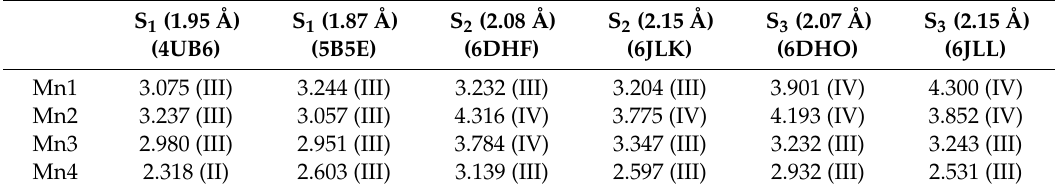
Table 1. Bond-valence sum (BVS) calculations on the structures of the OEC revealed at di ff erent resolutions in di ff erent S states. Roman numerals in parentheses indicate the assignment of the possible oxidation valences of four manganese ions in the OEC based on BVS calculations. All atomic coordinates were taken from the first monomer of PSII in the crystal structure data with the Protein Data Bank (PDB) codes: 4UB6 [50], 5B5E [54], 6DHF [53], 6JLK [52], 6DHO [53], and 6JLL [52],